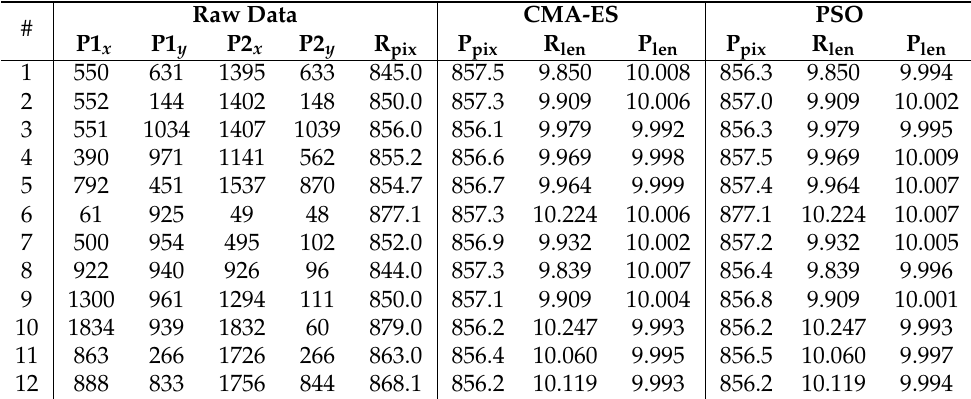
Figure 25. Twelve sample images, including a reference ruler, used for evaluating the image distortion algorithms. Table 13. Resultsonrealim age using CMA-ES and PSO. The first column (#) reports the measurement number (see Figure 25) while raw data are reported in the second column as